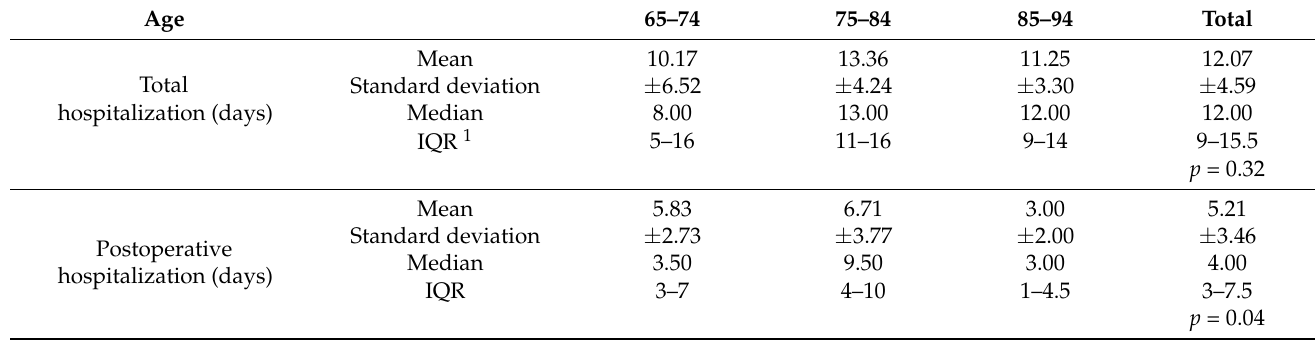
Table 4. Total and postoperative hospitalisation in the different age groups.